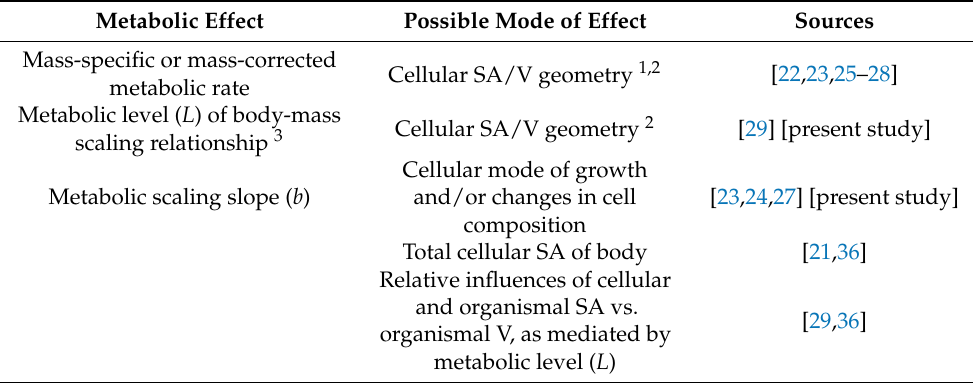
Table 1. Multiple ways that whole-body metabolic rate and its scaling with body mass may relate to cell